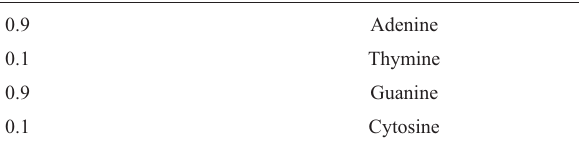
Table 4 - Nucleic base codification.